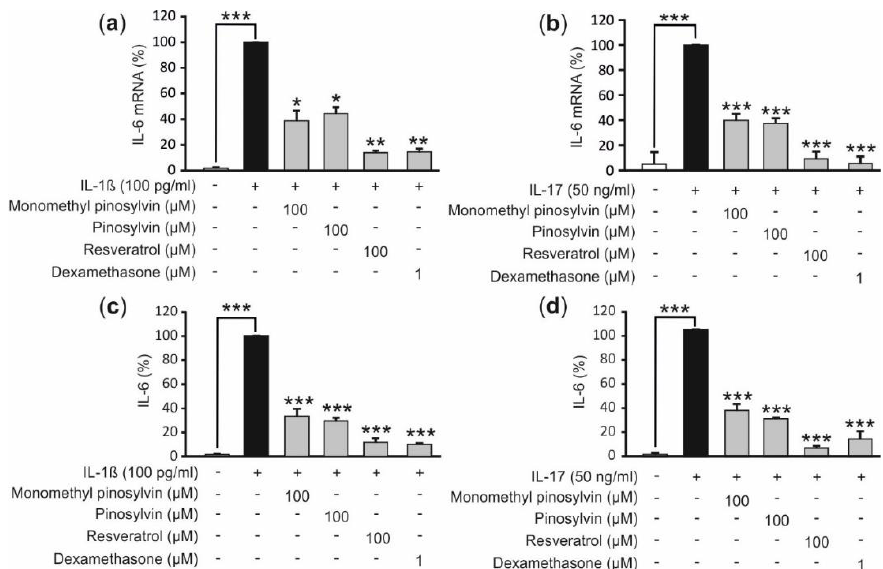
Figure 3. Effects of monomethyl pinosylvin, pinosylvin, resveratrol and the anti-inflammatory control compound dexamethasone in IL- 1β and IL -17 stimulated primary human OA chondrocytes on IL-6 expression at mRNA ( a and b ) and protein ( c and d ) level at time point 24 h. IL-6 mRNA was measured by quantitative reversed transcriptase polymerase chain reaction (RT-PCR) and the results were normalized against GAPDH mRNA. IL-6 concentrations in the culture media were measured by immunoassay. IL-6 levels were 12.5 – 25.8 ng/mL in IL- 1β and 2 .6 – 10.2 ng/mL in IL-17 stimulated cells in the absence of the tested compounds. Primary chondrocytes were isolated from cartilage samples obtained from three consequent donors and the experiments were performed in duplicate; n = 3 was used in the calculations. Results are expressed as mean +SEM. * p < 0.05, ** p < 0.01 and *** p < 0.001 as compared to cells treated with IL- 1β or IL -17 only.